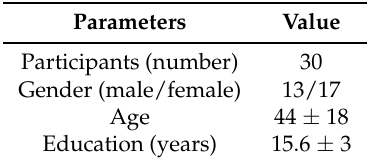
Table 2. Sample’s characteristics.